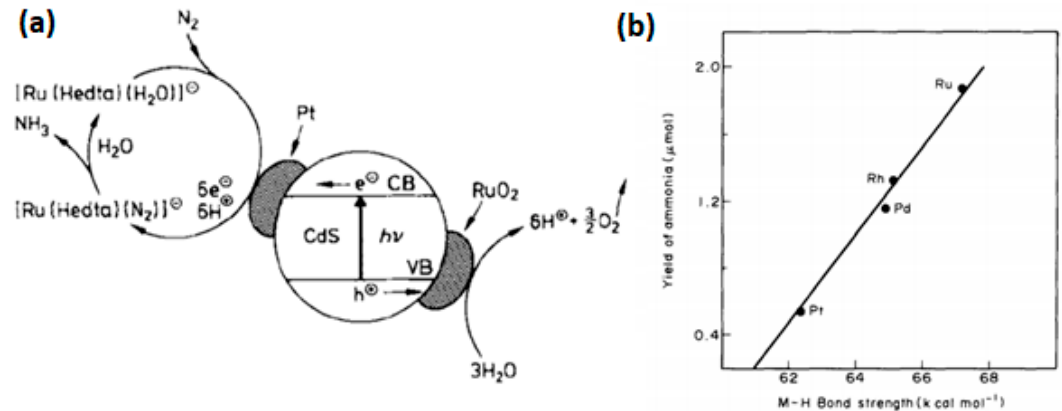
Figure 14. ( a ) the mechanism of photocatalytic N 2 fixation over CdS/Pt/RuO 2 [75]; ( b ) M–H bond Strength vs. yield ammonia [76]. (Reproduced with permission from the respective publishers).